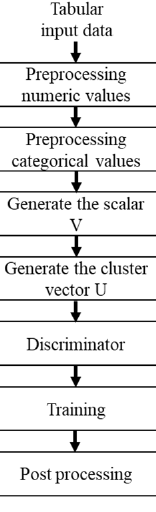
Figure 2. Tabular generative adversarial network (TGAN) working procedure.